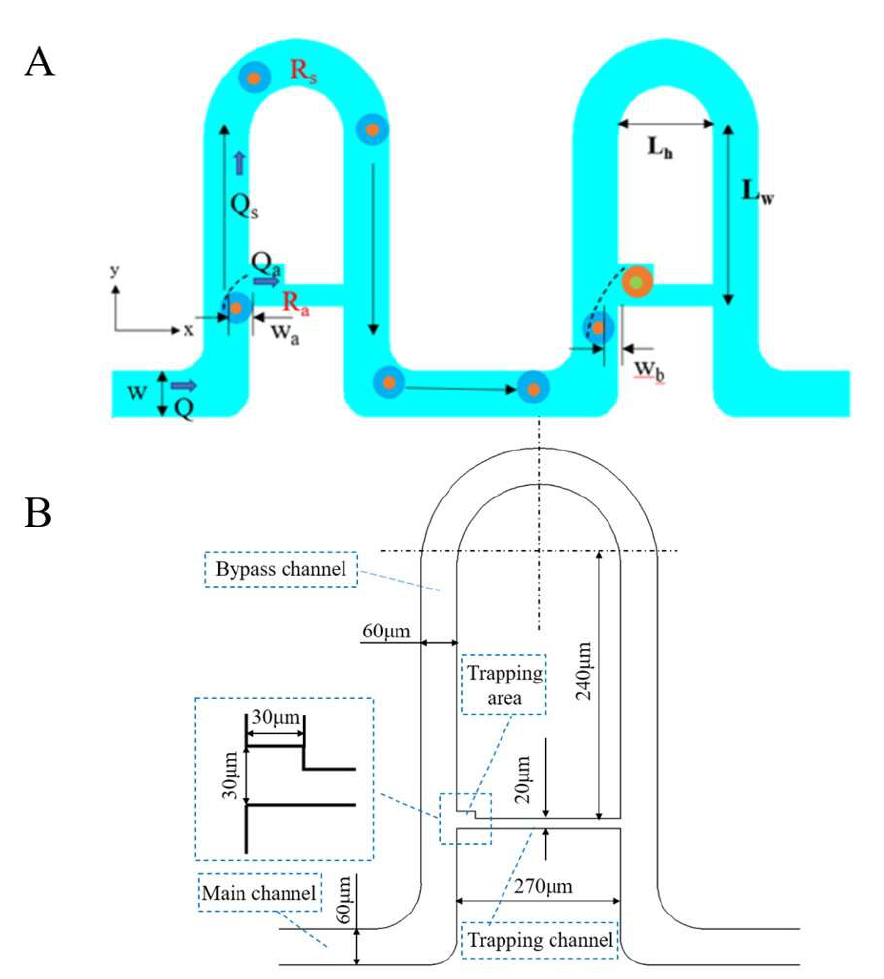
Figure 2. ( A , B ) Mathematical model of the trapping Figure 2. Mathematical model of the trapping channels.